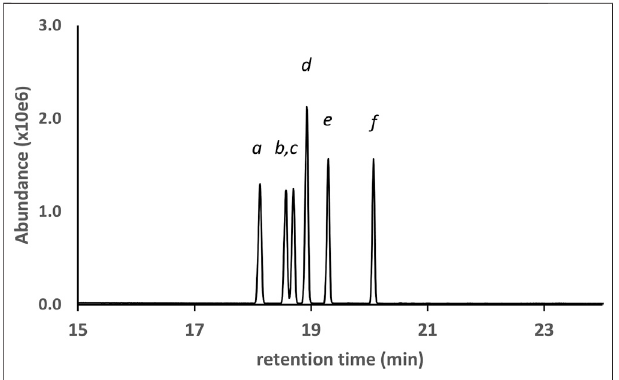
FIGURE2| GC-MSchromatogramfora25 μ g/mlstandardmixofseven positional and stereoisomeric THC monoTMS isomers. Peak labels: 6aR,10aR-d8THC( a ); 6aR,10aR-exoTHC( b ); 6aR,10aR-d9THC( c ); coeluted 9R- and 9S- d6a,10aTHC( d ); 6aR,9S-d10THC( e ); 6aR,9R-d10THC( f ). See text for